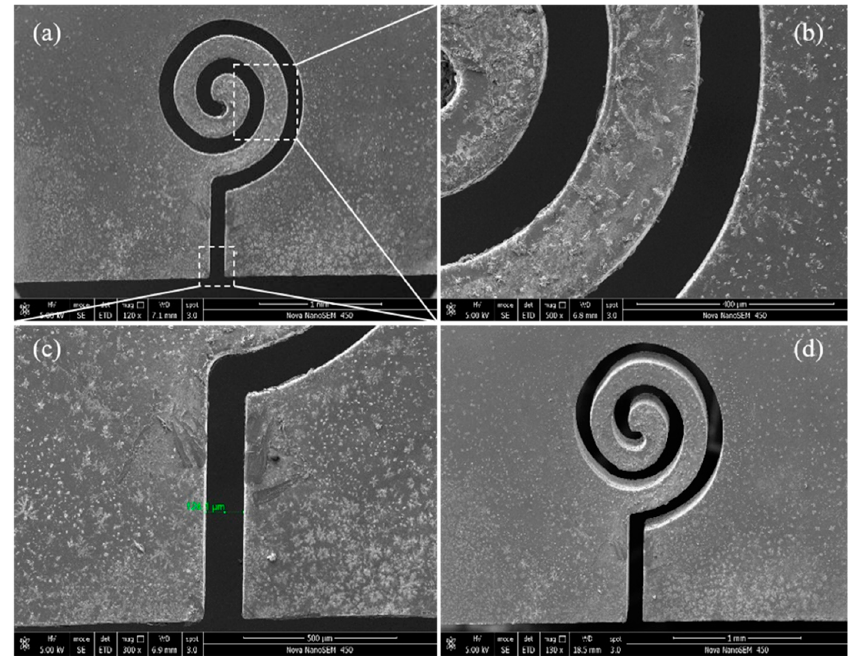
Figure 15. Micro planar coil structure and entrance slit width. ( a ) Front view; ( b ) Enlarged view of spiral part; ( c ) Enlarged view of entrance; ( d ) Rear view.